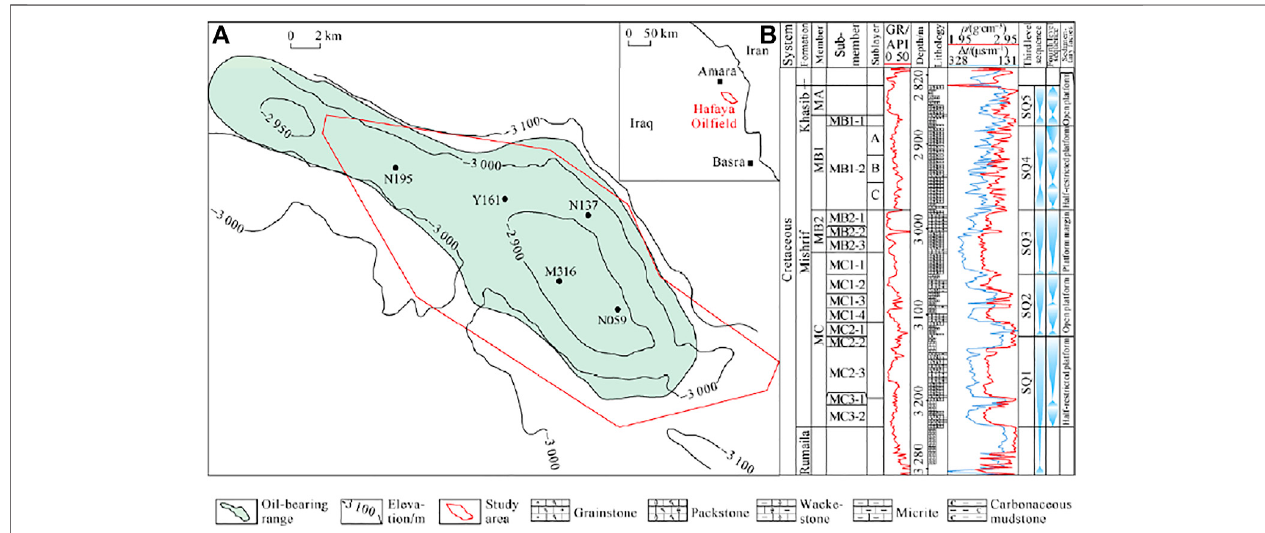
FIGURE 1 | Structural and well location map (A) and composite columnar section of the Mishrif formation (B) in the Halfaya Oil fi eld, Iraq. GR — natural gamma, ρ — denstiy; t — acoustic differential time (Sun et al., 2020).